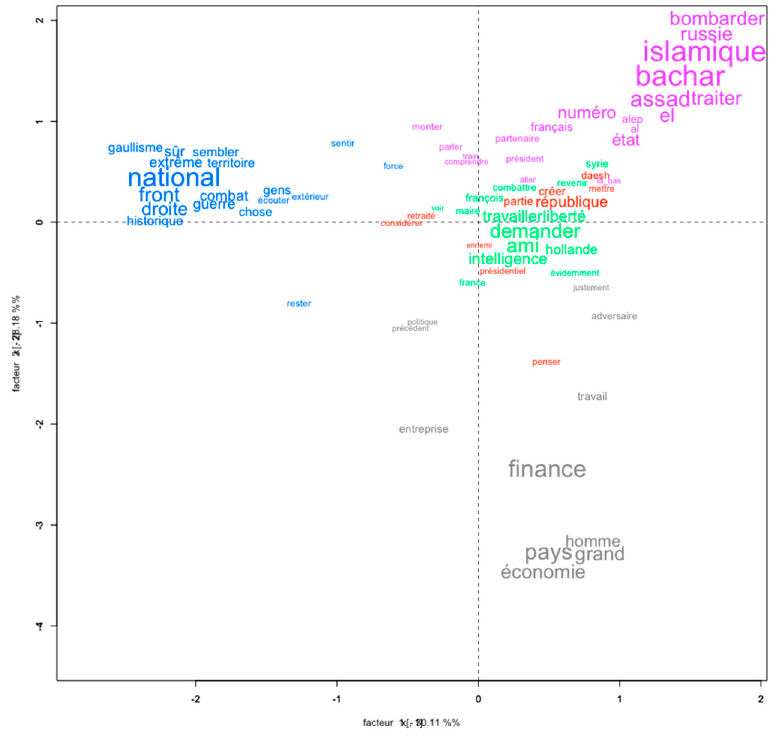
Figure 6. Factorial analysis of correspondences (FAC) of the thematics.